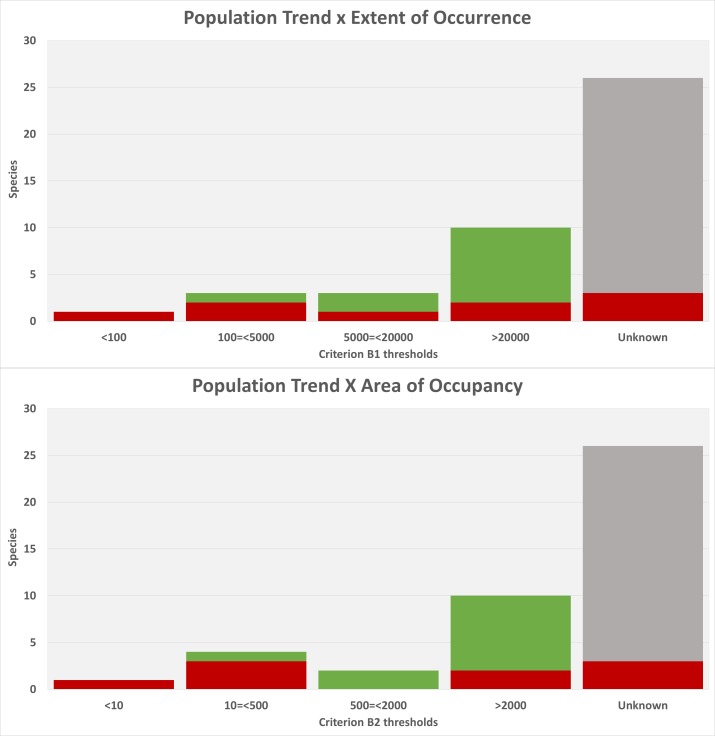
Range (EOO and AOO) categories of all species, arranged according to their population trends. Species classified as "In decline" in red, species classified as "Stable" in green, species classified as "Unknown" in grey.